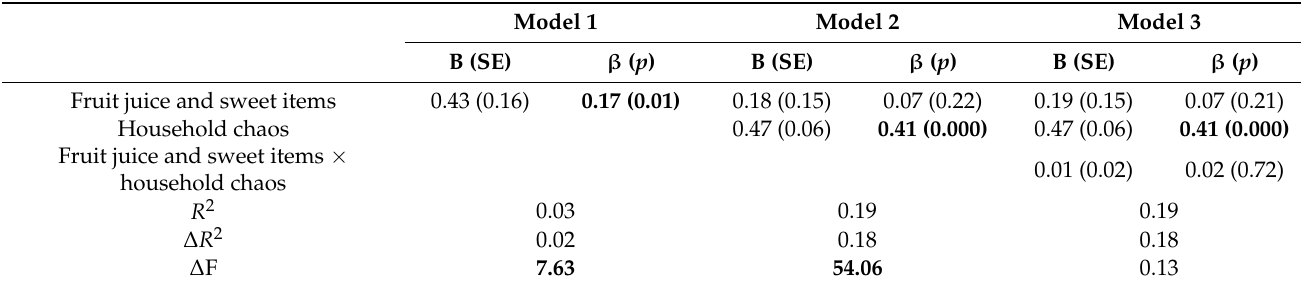
Table 7. Multiple Regression Analyzing Associations Between Fruit Juice and Sweet Items, Household Chaos, and Inhibitory Self-Control Index (ISCI).